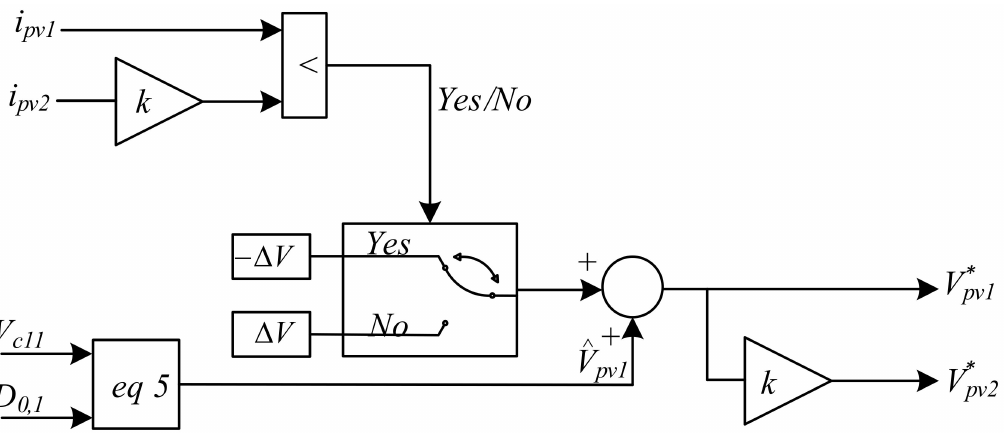
Figure 7. Flowchart of the proposed enhanced dual-string maximum power point tracking (eDS-MPPT)